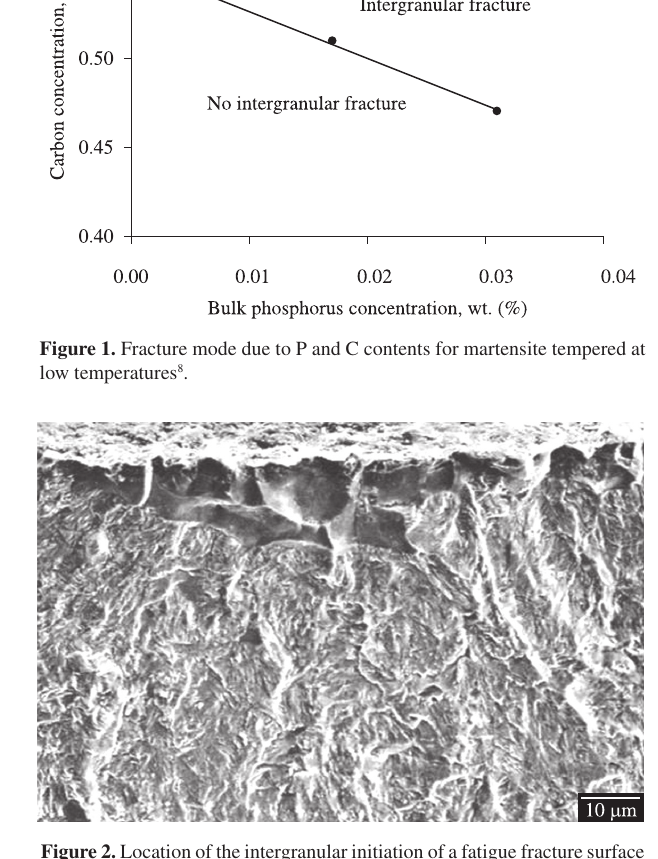
Figure 2. Location of the intergranular initiation of a fatigue fracture surface of a specimen of SAE 4320 carburized steel 10 .